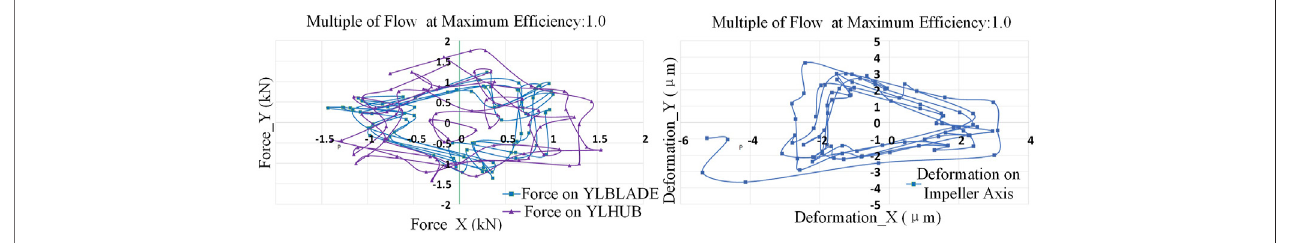
FIGURE 10 | Radial force and radial centroid trajectory of impeller.